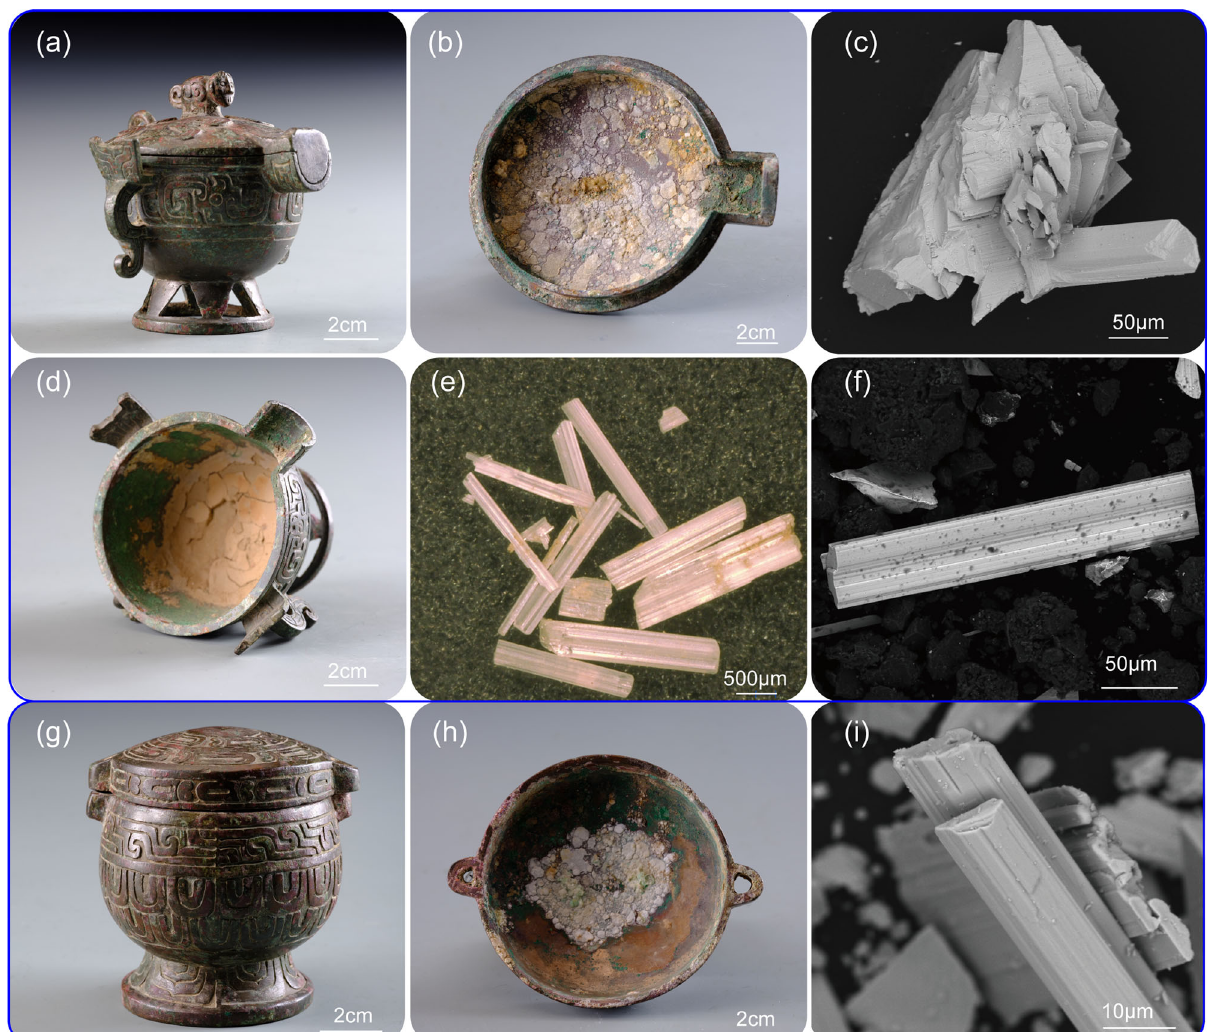
Fig. 4 Some cosmetic bronze containers in Liangdaicun site and lead white residue inside. a The miniature bronze container of Fu (code M26:138); b the white residue (LW-1a) on its lid; c the SEM observation of sample LW-1a with multiple stacks layout; d numerous pure lead white residue particles scattered within the soil off the bottom of M26:138; e some elongated needles and prismatic lead white (LW-1c) gently separated from the soil of d ; f the SEM observation of sample LW-1c; g the miniature bronze container of round-foot jar (code M26:137); h the white residue (LW-2a) on its lid; i the SEM observation of sample LW-2a with prismatic shape.